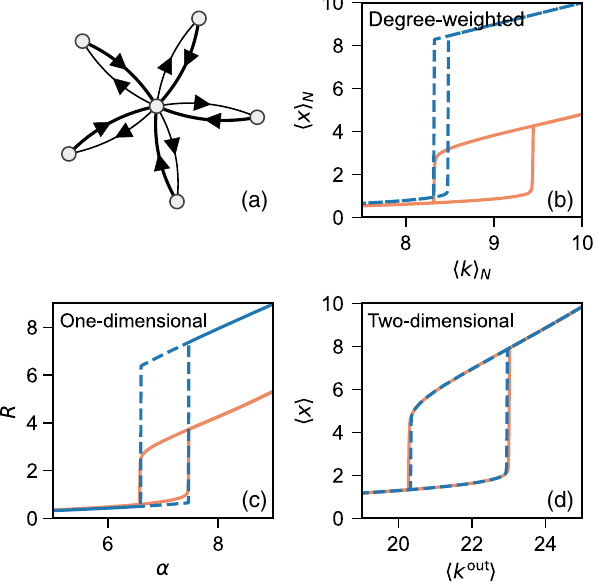
FIG. 3. (a) Schematization of the star network of N ¼ 6 nodes where the edge weight toward the core is twice the weight of an edge toward the periphery. (b) Average neighbor activity at equilibrium as a function of its structural parameter using the degree-weighted reduction of Gao et al. [9]. (c) Dominant eigen- vector weighted activity at equilibrium R (cid:3) ¼ v T D x (cid:3) as a function of the dominant eigenvalue α for the one-dimensional reduction [Eq. (5)]. (d) Average activity at equilibrium obtained by a combination of two observables h x i (cid:3) ¼ N − 1 ½ R (cid:3) 1 þ ð N − 1 Þ R (cid:3) 2 (cid:2) , as a function of the average out-degree h k out i ¼ N − 1 ½ α 1 þ ð N − 1 Þ α 2 (cid:2) computed using the two-dimensional reduction formalism [Eq. (28b)]. Solid lines are results from simulations, and dashed lines are theoretical predictions. The network dynamics is the Cowan-Wilson model with τ ¼ 1 , μ ¼ 3 [Eq.